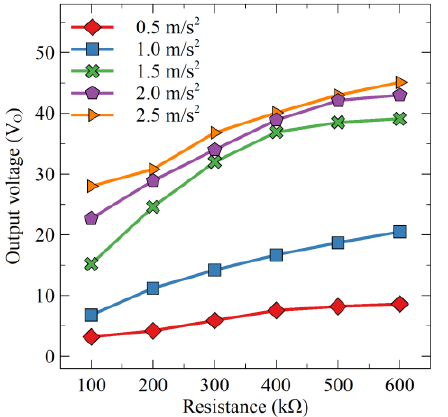
Figure 15. Resistance versus output voltage scenario of Test 2.